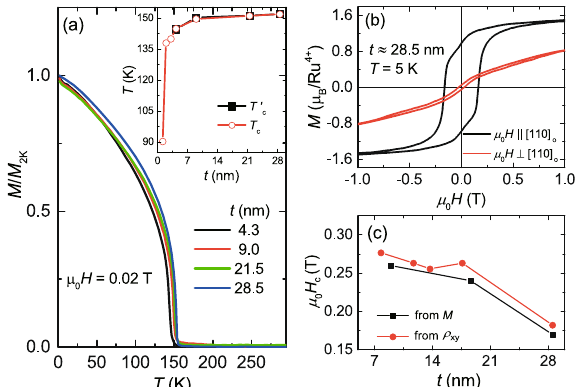
Figure 7. The magnetic properties of SRO films on STO. ( a ) The magnetization as a function of T for different t values, where the M data were measured with an applied field of µ 0 H = 0.02 T along SRO [110] o . Inset shows the variation of transition temperature with respect to t extracted from the derivative of the M ( T ) data and from the ρ( T ) data of Fig. 6(b). ( b ) M-H hysteresis loops for t ≈ 28.5 nm of SRO film at T = 5 K measured for H ⊥ SRO [110] H (cid:31) SRO [110] o and o directions, revealing a magnetic easy axis along SRO [110] o . ( c ) The t dependent coercive field H c extracted from M and ρ xy data with µ 0 H (cid:31) SRO[110] o . H c gradually decreases from about 0.28 to 0.18 T as t increases from about 7.8 to 28.5